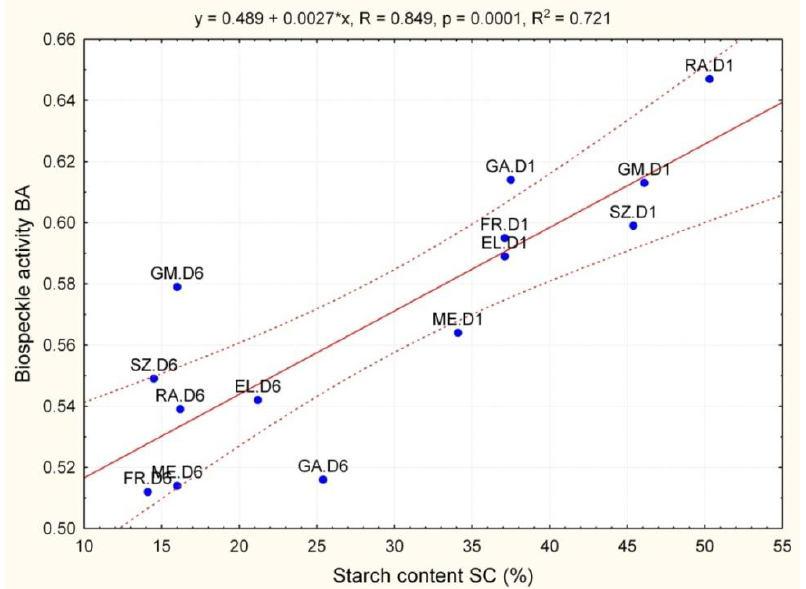
Figure 3. Relation of biospeckle activity BA with starch content SC for apples: EL—‘Elstar’, FR—‘Free Redstar’, GA—‘Gala’, GM—‘Gold Milenium’, ME—‘Melfree’, RA—‘Rajka’ and SZ—‘Szampion’. D (number)—day of shelf